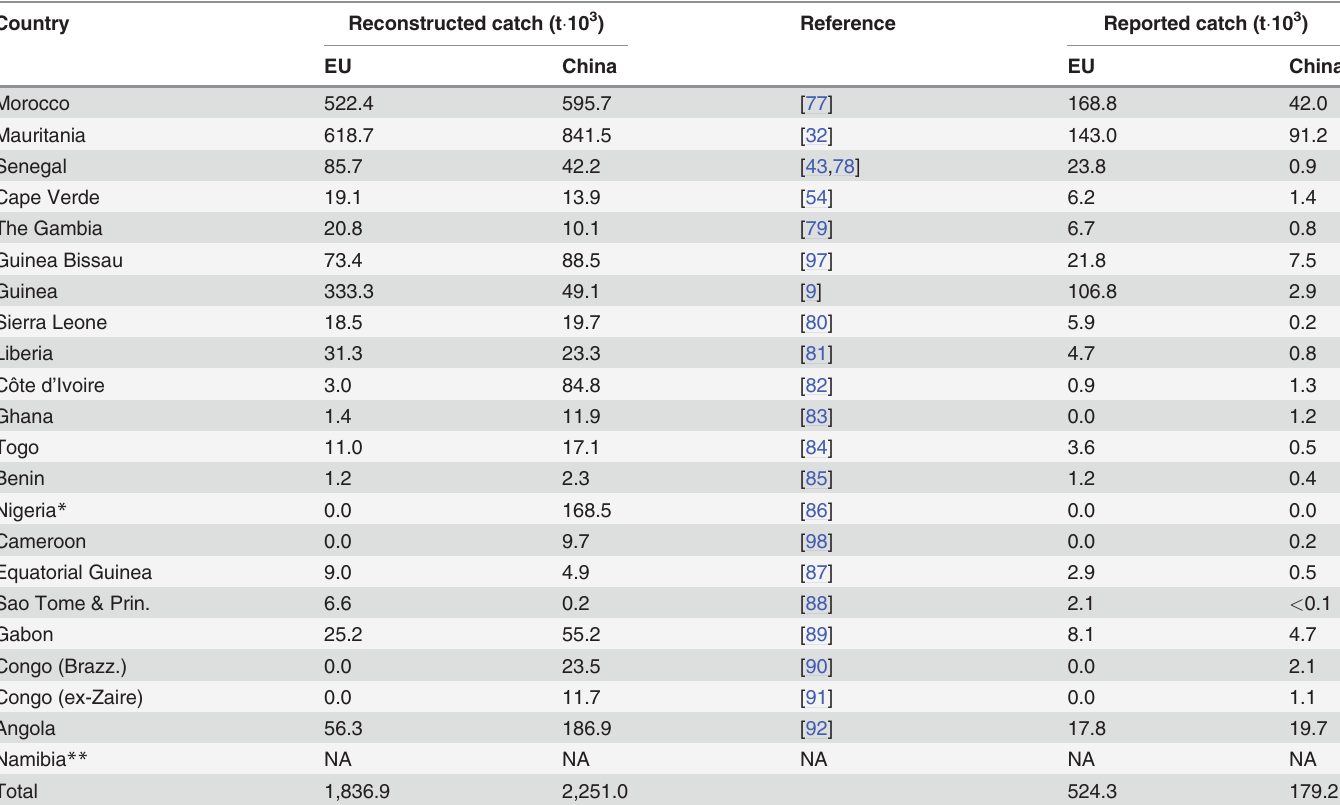
Table 1. Average annual reconstructed and reported catches (2000 – 2010) by the EU and China from West African waters (t (cid:1) 10 3